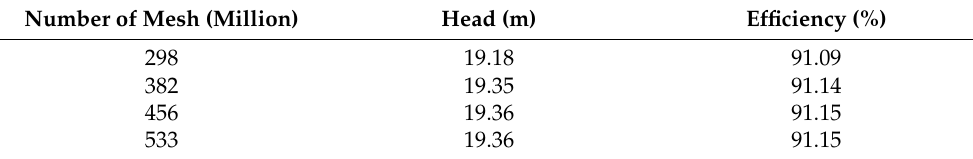
Table 2. Mesh independence result.